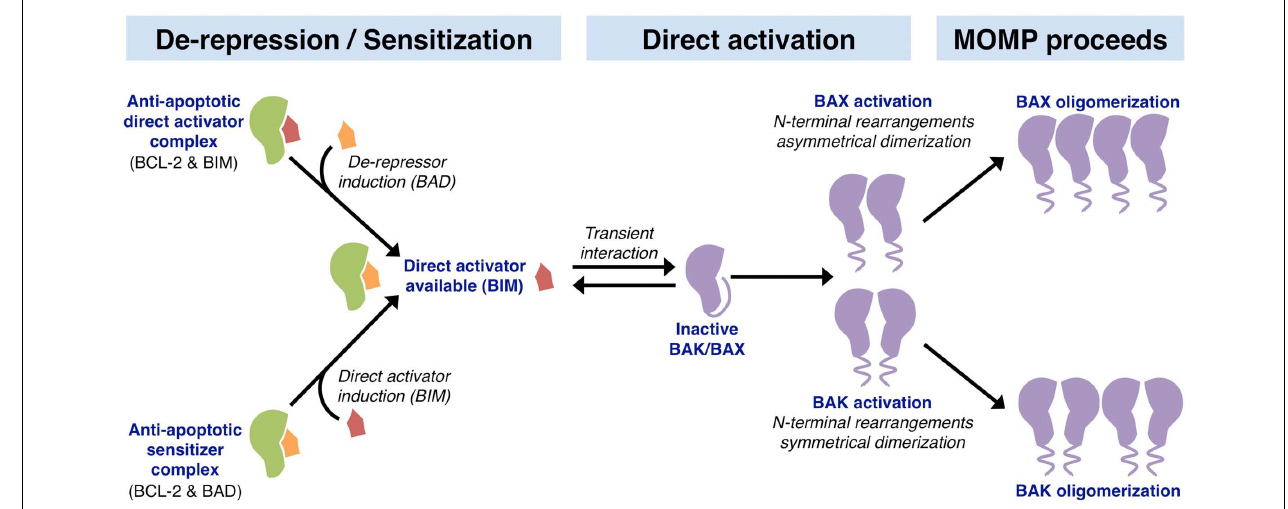
direct activator BH3-only proteins induced following apoptotic stimulation (e.g., BIM), thus lowering the threshold level of direct activator necessary to activate the effectors BAK and BAX. Unbound direct activator BH3-only proteins function in the direct activation of BAK and BAX through a transient interaction.These interactions lead to conformational changes involving N-terminal rearrangement, which exposes the BH3 domain of BAK and BAX. Activated BAK monomers pair symmetrically, and oligomerize as sets of dimers to permeabilize the outer mitochondrial membrane leading to MOMP. In contrast, activated BAX monomers pair asymmetrically to oligomerize and promote